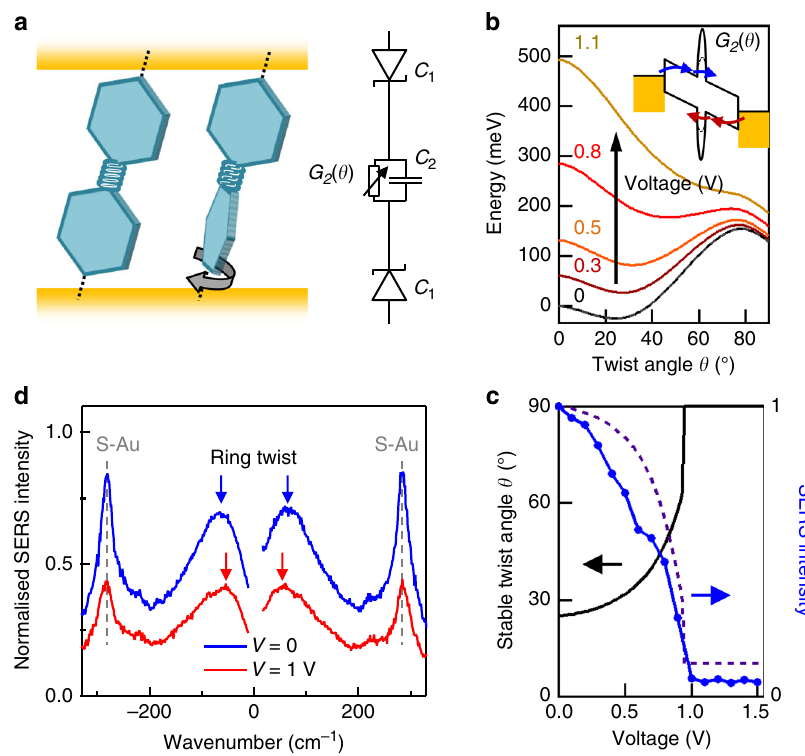
Fig. 5 Circuit model compared to SERS. a Circuit model for BPDT molecules in the junction gap, with each section 1 – 3 of the junction characterised by its conductance and capacitance; central CC bond has variable conductance. b Calculated energy pro fi le U ¼ U DFT θ ð Þ þ U Q ð θ Þ as voltage is increased, shifting stable angle towards larger twists. c Voltage dependence of DFT twist angle θ eq V ð Þ (black) and resulting SERS intensity (at 1590 cm − 1 ) from DFT (dashed) compared to experiment (points). d Voltage-induced shift of central CC twist vibration to smaller wavenumbers (arrows). SERS normalised using a T = 320 K thermal ratio between Stokes and